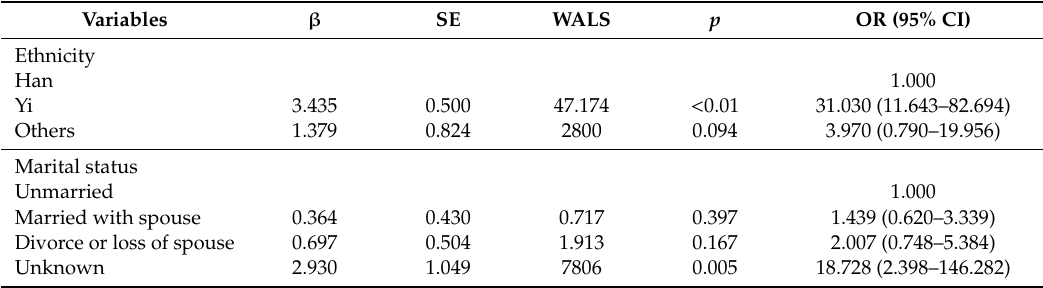
Table 4. Univariate and multivariate logistic regression analysis of factors a ff ecting Hepatitis C